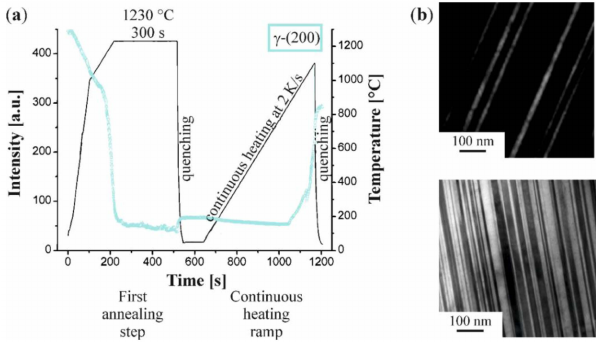
Figure 13. Temperature profile applied during the heat treatment of a TNM alloy, shown superimposed by the intensity evolution of the γ -(200) peak (blue) ( a ). The heat treatment was conducted in two steps and resulted in the precipitation of fine γ lamellae. Exemplary TEM images show the presence of only few γ lamellae in the supersaturated α 2 grains after quenching ( b , top). After annealing, the number and volume fraction of fine γ lamellae has significantly increased ( b , bottom). (Reproduced with permissions from Reference [52]. Copyright © Wiley-VCH Verlag GmbH & Co. KGaA, Weinheim, Germany,